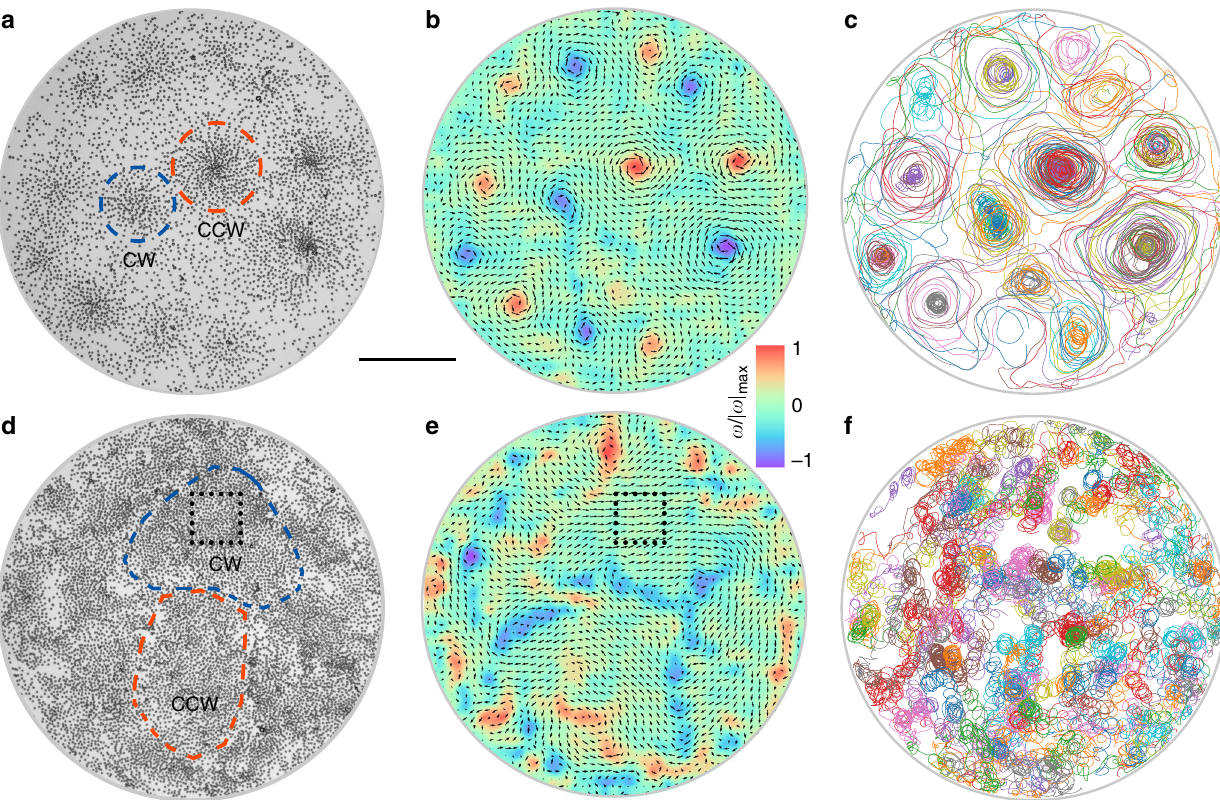
Fig. 2 Emergent self-assembled patterns comprised of chiral rollers. a , d Experimental image of the vortex and rotating fl ock phases spontaneously formed in the ensemble of active chiral rollers energized by the electric fi eld. Both types of chiral states (CW and CCW) of vortices or rotating fl ocks are simultaneously present in the system. See also Supplementary Movies 1 – 6. b Superimposed velocity (arrows) and vorticity (background color) fi elds of the chiral rollers shown in ( a ). Quasi-antiferromagnetic order of vortex chiralities is observed. c Typical trajectories of the pear-shaped rollers in a vortex phase. Only 2% of particle trajectories are shown. In a – c particle area fraction is 0.108 and electric fi eld strength is 1.92 V μ m − 1 . e Velocity fi eld of the chiral rollers in rotating fl ocks is illustrated by arrows. The direction of particle motions are synchronized within each fl ock. Background color depicts a vorticity fi eld in the rotating fl ocks phase. f Trajectories of pear-shaped rollers in a rotating fl ocks phase. 0.5% of the trajectories are shown for clarity. In d – f particle area fraction is 0.254 and electric fi eld strength is 2.60 V μ m − 1 . Blue and red dashed shapes depict typical CW and CCW vortices or fl ocks, respectively. Black doted squares mark the position of the rotating fl ock region shown in detail in Fig. 3i. Scale bar is 0.5